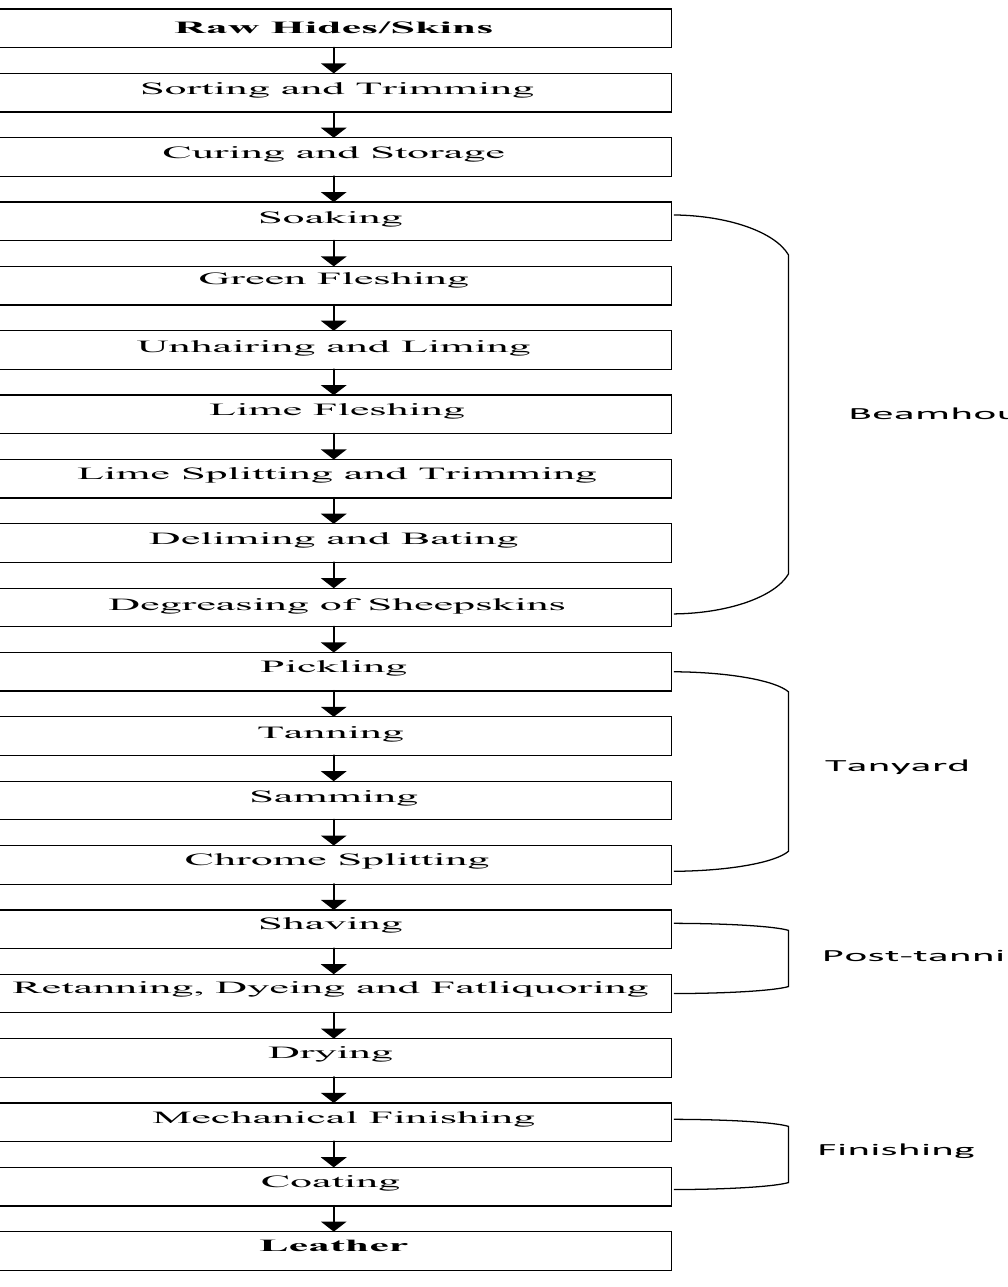
Fig. 1 Process steps in leather tanning (Rydin et al.